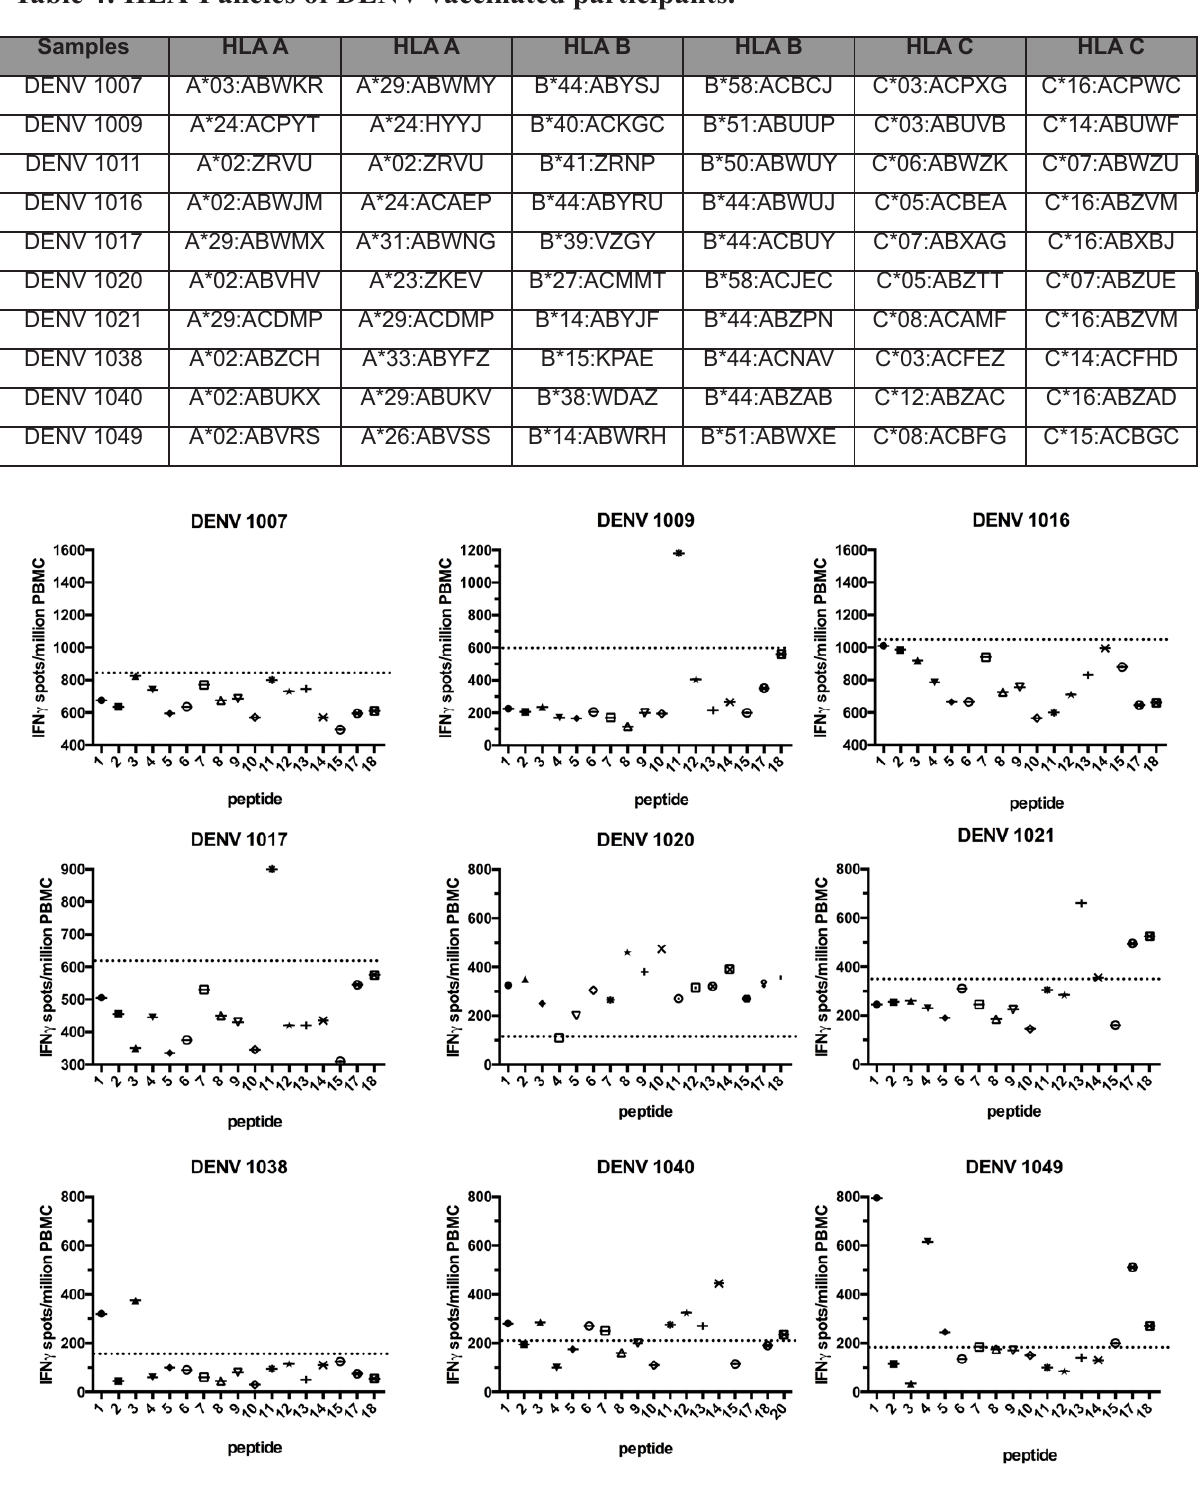
Figure 3. Identification of DENV-ZIKV Cross-reactive Peptides. PBMCs from DENV-vaccinated sub- jects were stimulated with peptides 1-18 and IFN γ production was evaluated by ELISPOT. The dashed line represents the background level of IFN γ in the absence of stimulation multiplied by